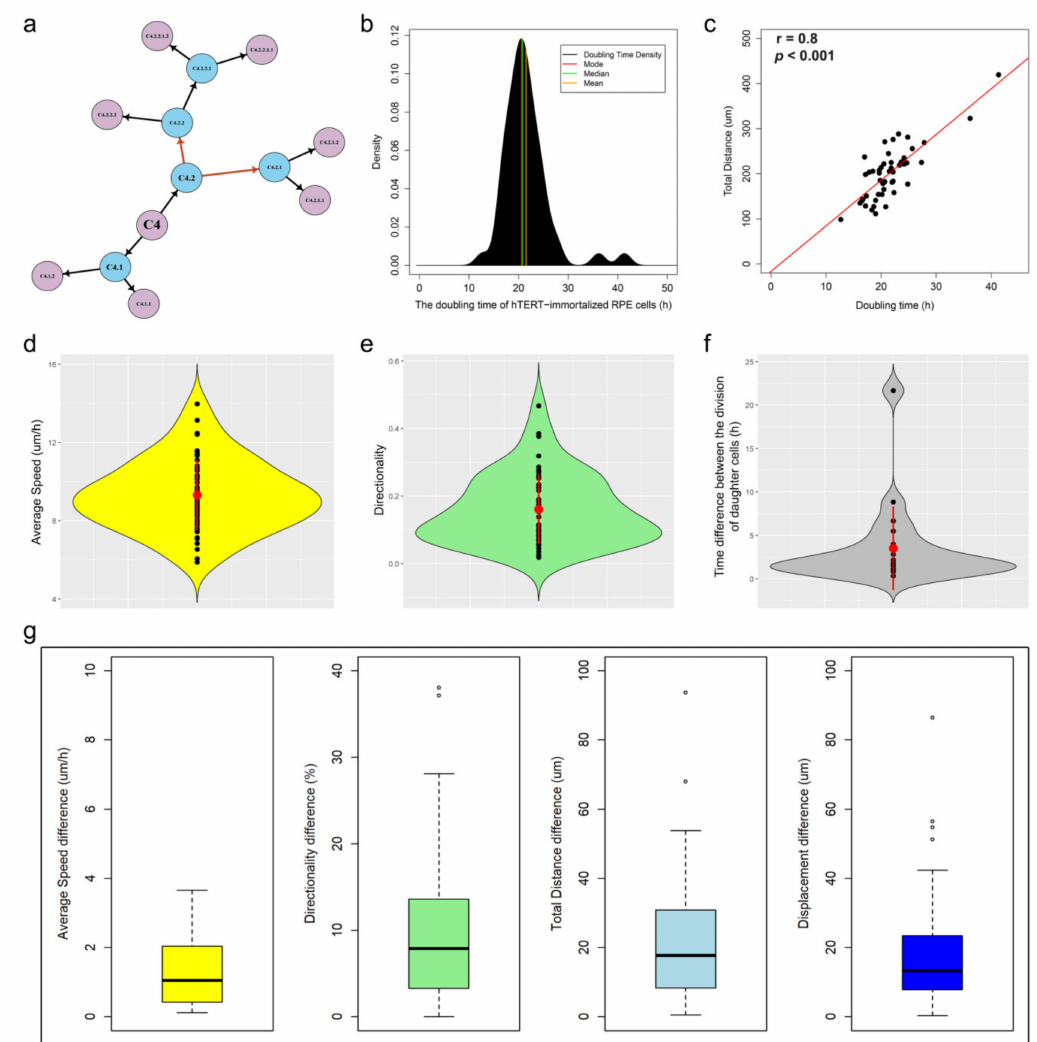
Figure 5. Characterizing the trajectory movement of retinal pigment epithelial (RPE) cells. ( a ) Lineage tree of cell #4 and its descendants. The length of the arrows is associated with the time till cell division. Red arrows show a deviation in the synchronization between daughter cells. ( b ) Density plot of the doubling time of RPE cells ( n = 48). ( c ) Correlation between RPE doubling time and their total distance (Spearman’s rank correlation coefficient = 0.8). ( d , e ) Violin plots showing the median and the interquartile range of the average speed and directionality of RPE cells. ( f ) Violin plot showing the time difference between divisions of RPE daughter cells ( n = 20 pairs). ( g ) Boxplots showing the heterogeneity between of RPE daughter cells ( n = 33 pairs) according to four migration measures of total distance, displacement, directionality, and average